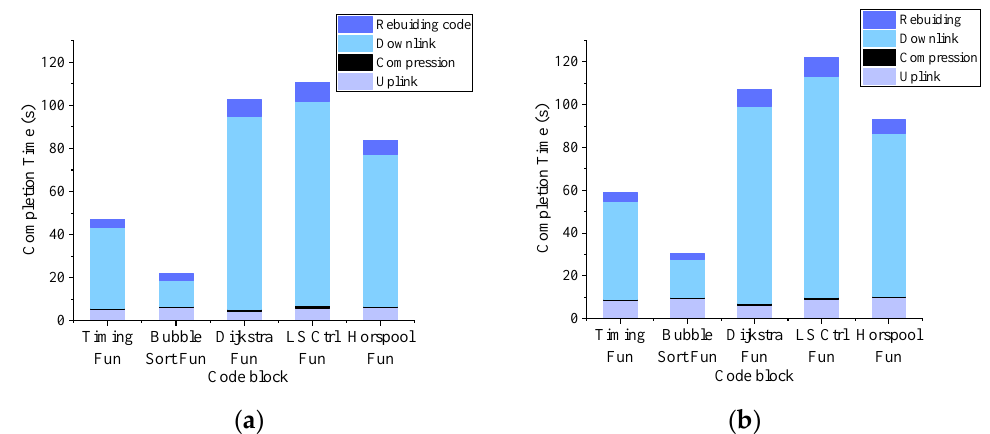
( b ) Figure 8. ( a ) Transmission rate in downlink. ( b ) Transmission rate in uplink. In the uplink, we test OOK, DH-PIM, and modified DH-PIM by transmitting feedback data in five different debugging cases. It is obviously that the amount of transmitted data us- ing DH-PIM cannot exceed using OOK under same slots. As shown in Figure 8b, the trans- mission rate of OOK is faster than DH-PIM. The modified DH-PIM has a slightly higher trans- mission rate than DH-PIM, and its BER is significantly lower than that of DH-PIM. Figure 9 shows the debugging completion time, which consist of downlink/uplink transmission, compression and local rebuilding time. We complete VLC-based debugging interaction under outdoor and indoor environments with different ambient light inten- sity. The whole procedure of debugging interactions includes: (1) The node sends the mes- sage “Update: xx fun” to the smartphone; (2) the smartphone firstly compresses the code block of the corresponding function (the size of code blocks is shown in Table 2), and then transmits the compressed data to the sensor node; (3) the sensor node decompresses the received data and locally rebuilds the program image. As shown in Figure 9, the most time-consuming process is the transmission of the debugging codes. In contrast, the code block’s compression occupies a small time period due to the computing power of